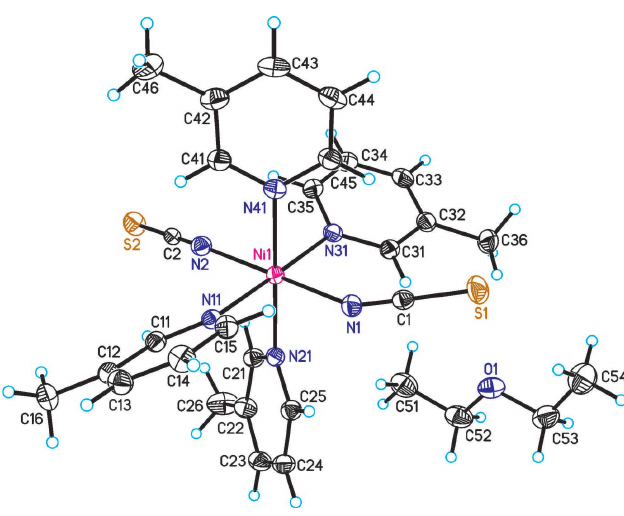
Figure 1 The molecular structure of compound 1 with labeling and displacement ellipsoids drawn at the 50% probability level. Symmetry code: (A) (cid:3) x + 1, y , (cid:3) z +